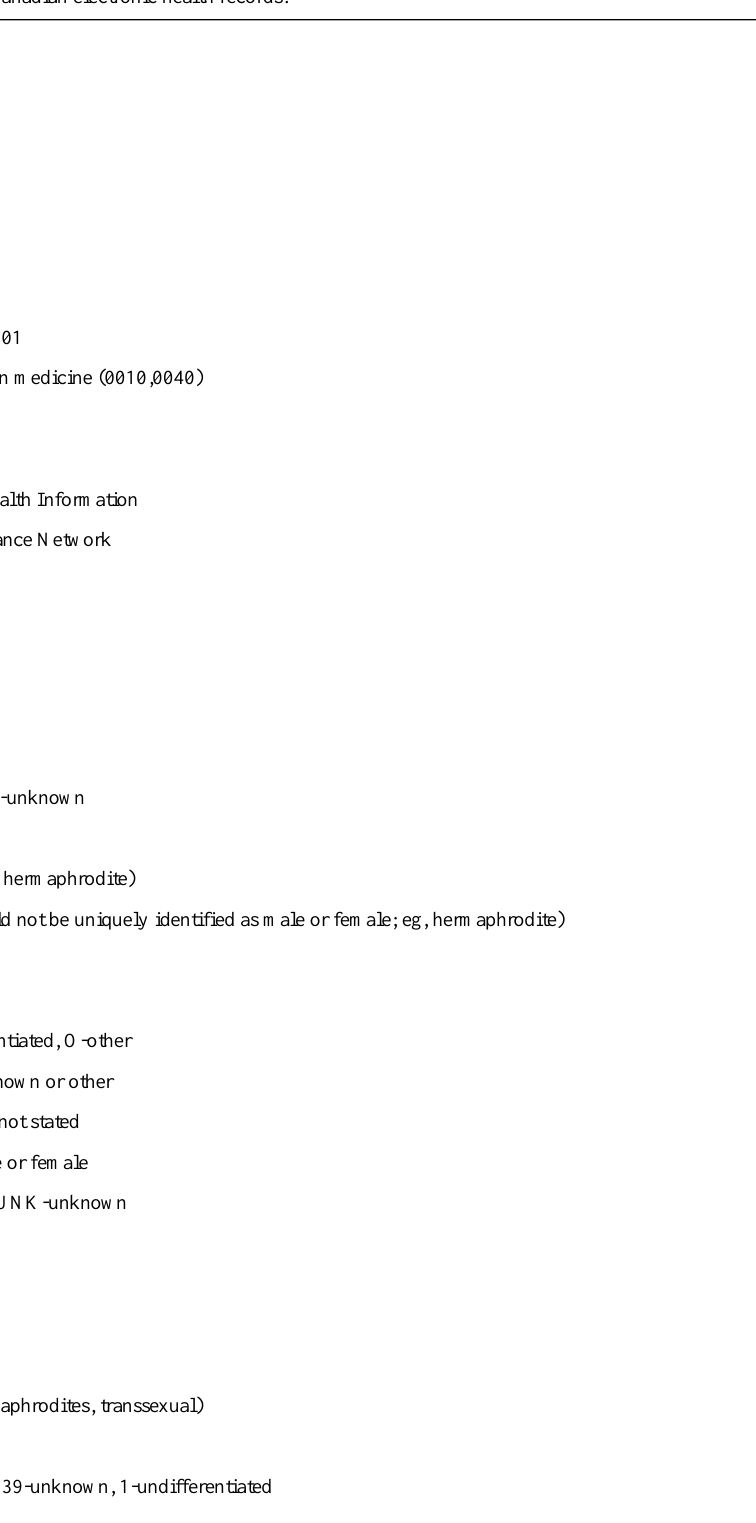
Textbox 1. Summary of definitions for sex in Canadian electronic health